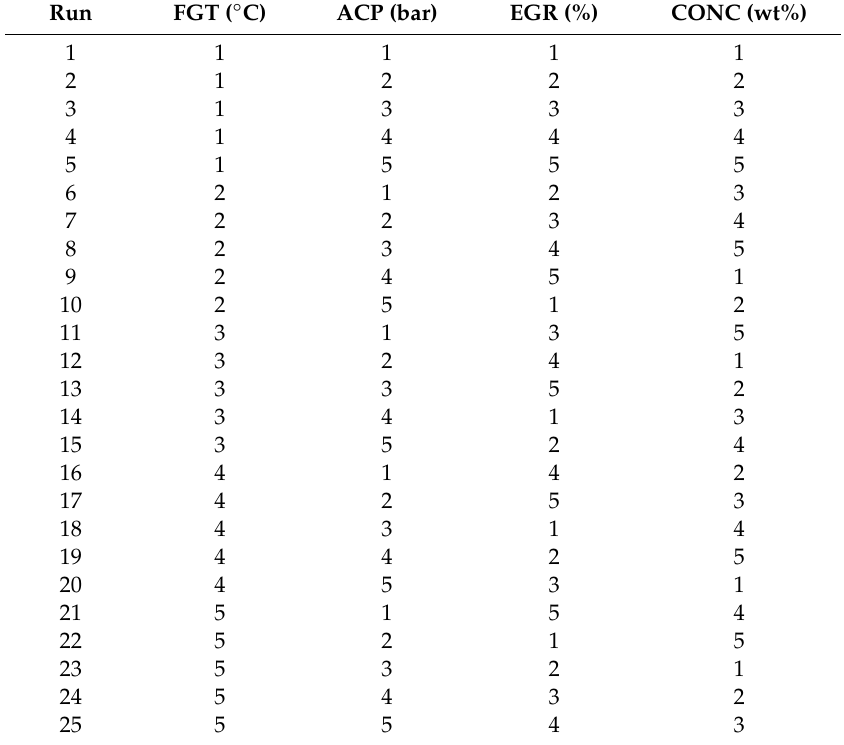
Table 3. Orthogonal array illustrating the configuration of the